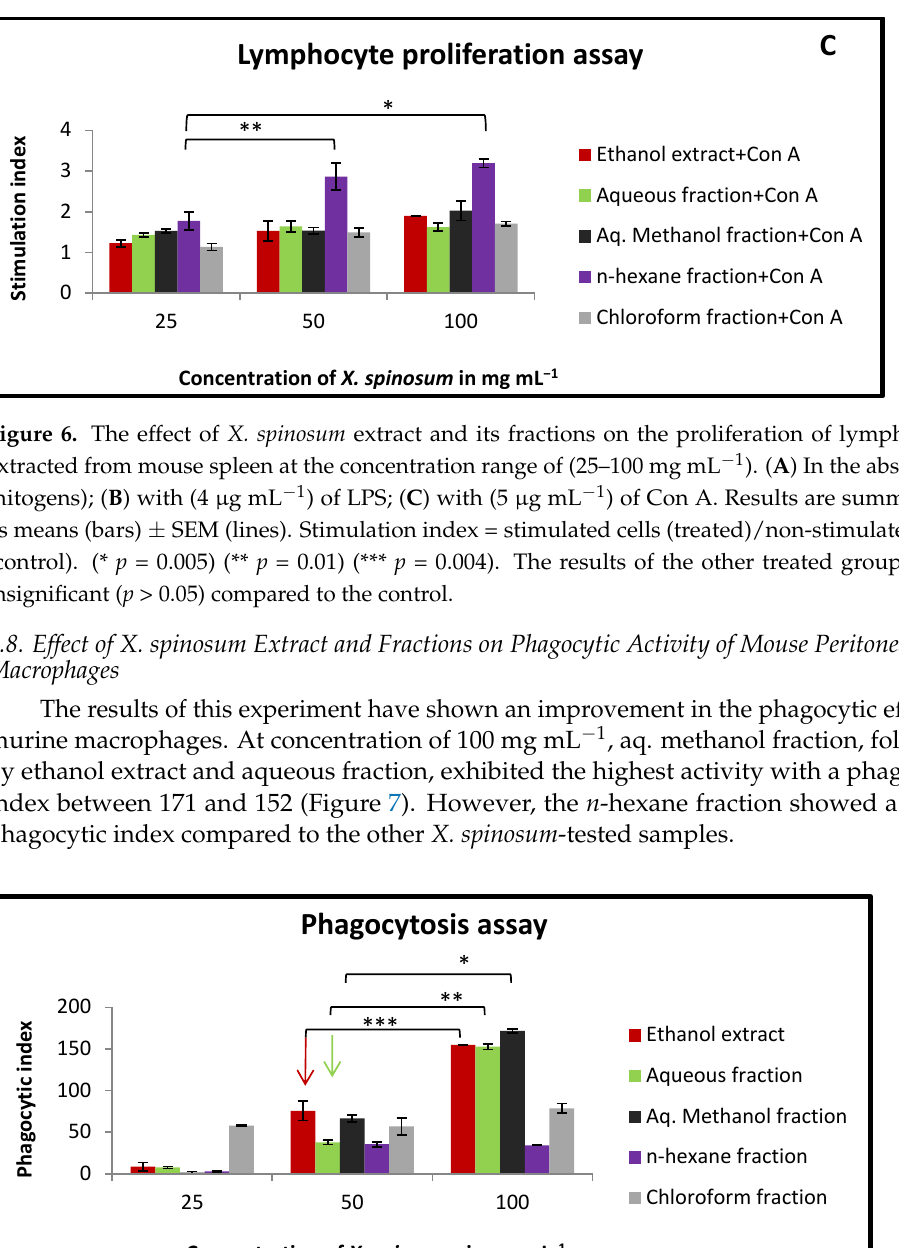
Figure 7. In vitro phagocytic assay using nitro blue tetrazolium (NBT) reduction test of peritoneal macrophages treated with various concentrations (25–100 mg mL − 1 ) of X. spinosum extract and fractions. Aqueous methanol fraction had the highest phagocytic index (171). Results are expressed as means (bars) ± SEM (lines). Phagocytic index = (OD sample − OD control)/OD control × 100. (* p = 0.002) (** p = 0.007) (*** p = 0.004).